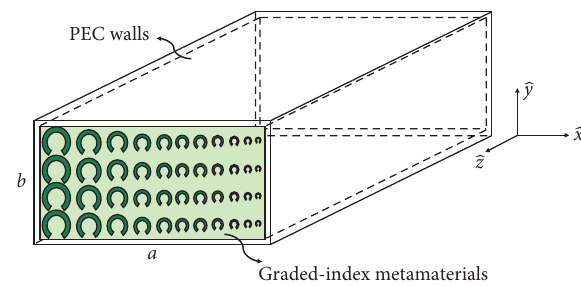
Figure 1: Rectangular waveguide filled with a metamaterial with a graded refractive-index profile.